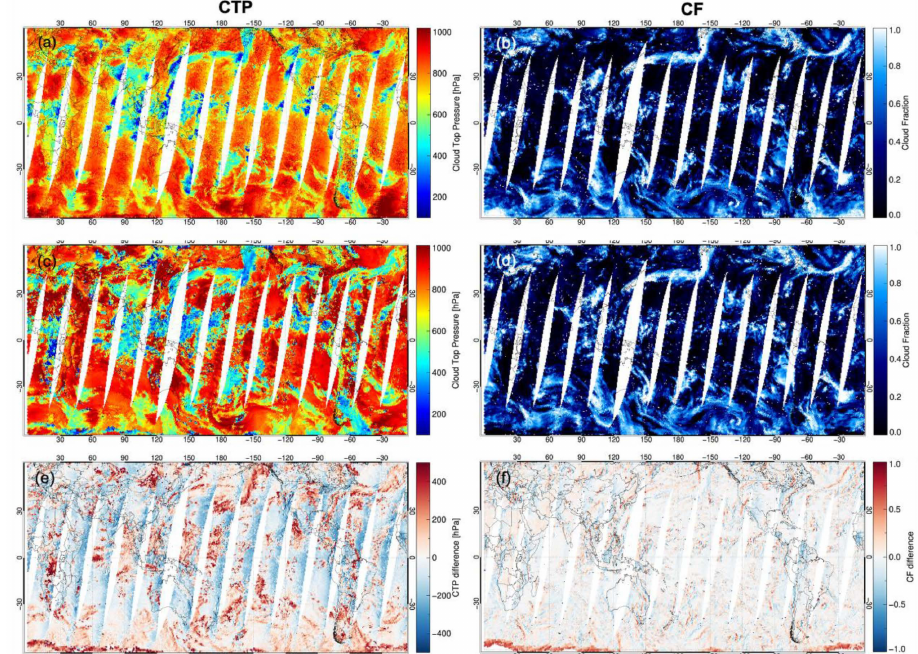
Figure 3. Retrieval result of CTP and cloud fraction (CF) by ( a , b ) fast cloud retrieval algorithm using a triplet of wavelengths of the O 2 –O 2 band around 477 nm (CLDTO4), ( c , d ) Global Ozone Monitoring Experiment-2 (GOME-2) Fast Retrieval Scheme for Clouds from the Oxygen A band (FRESCO), and ( e , f ) difference between CLDTO4 and FRESCO on 20 September